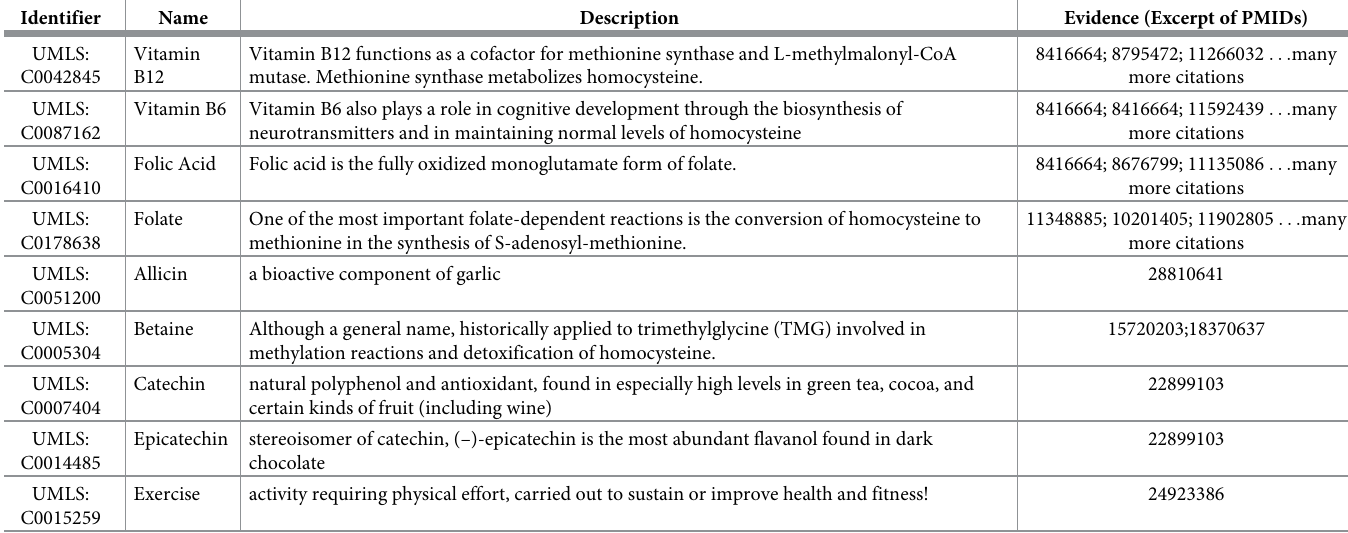
Table 3. The list of selected subject concepts from statement results from Table 2 example query step 5, given as inputs to example query step 6, to retrieve state- ment evidence of associated literature